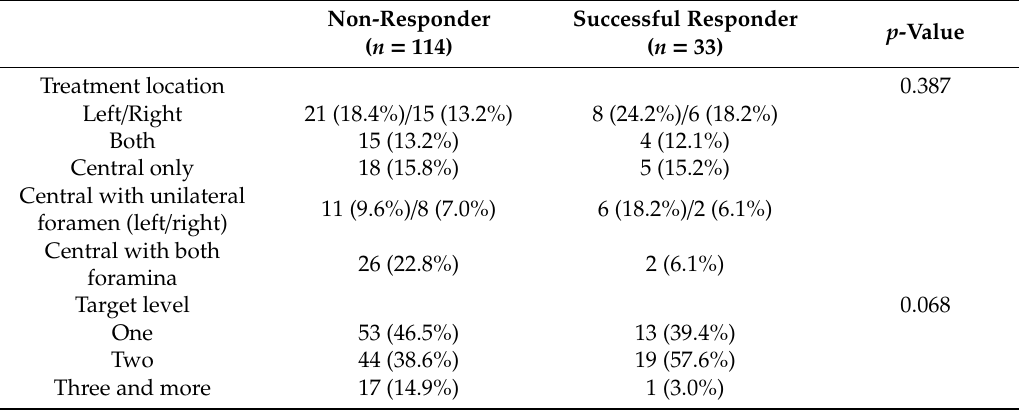
Table 4. Intervention characteristics of the non-responders and the successful responders at six months after combined epidural adhesiolysis and balloon decompression in patients with lumbar post-laminectomy